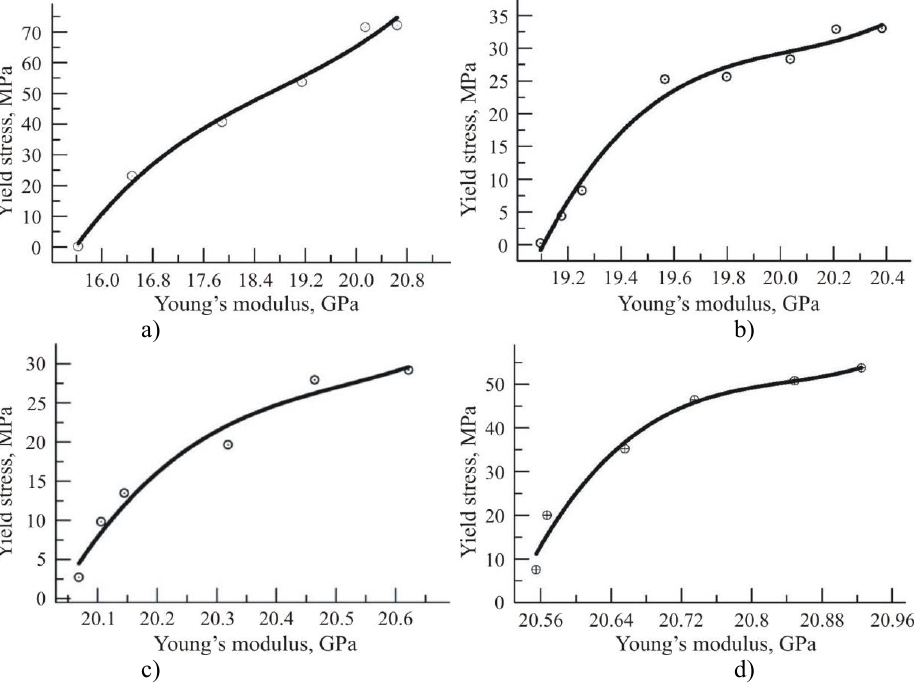
Fig. 5. Approximation of the yield stress and Young’s modulus dependence at different temperatures: a – 20 о С; b – 40 о С; с – 50 о С; d –70 о